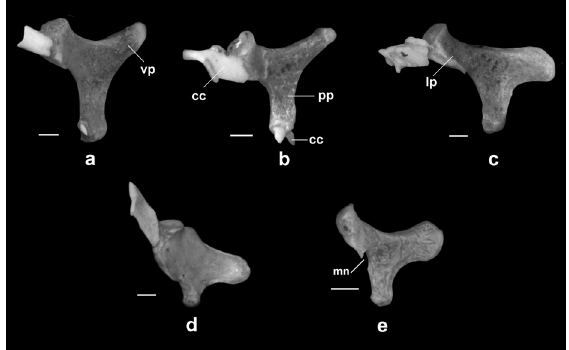
Figure 10 - Lateral view of manubrium of sternum: a . Desmodus rotundus ; b . Diaemus youngi ; c . Chrotopterus auritus ; d . Artibeus planirostris ; e . Anoura caudifer . Acronyms: cc: costal cartilage; lp: lateral process; mn: medial notch; pp: posterior process; vp: ventral process. Scale bar represents 1